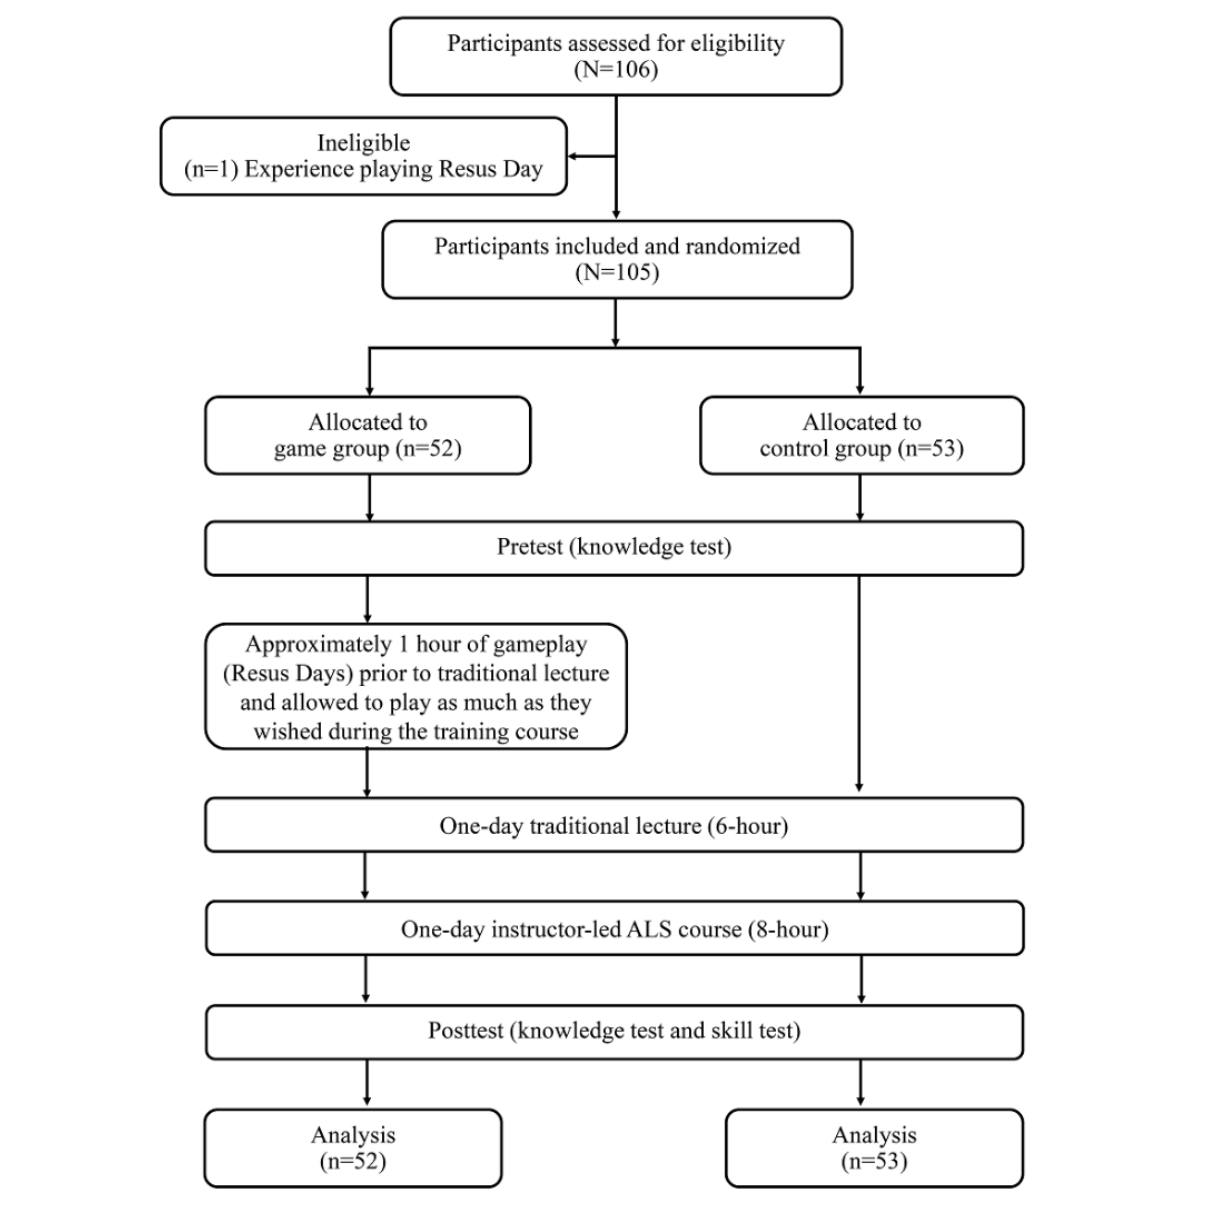
Figure 2. Flow diagram of participant